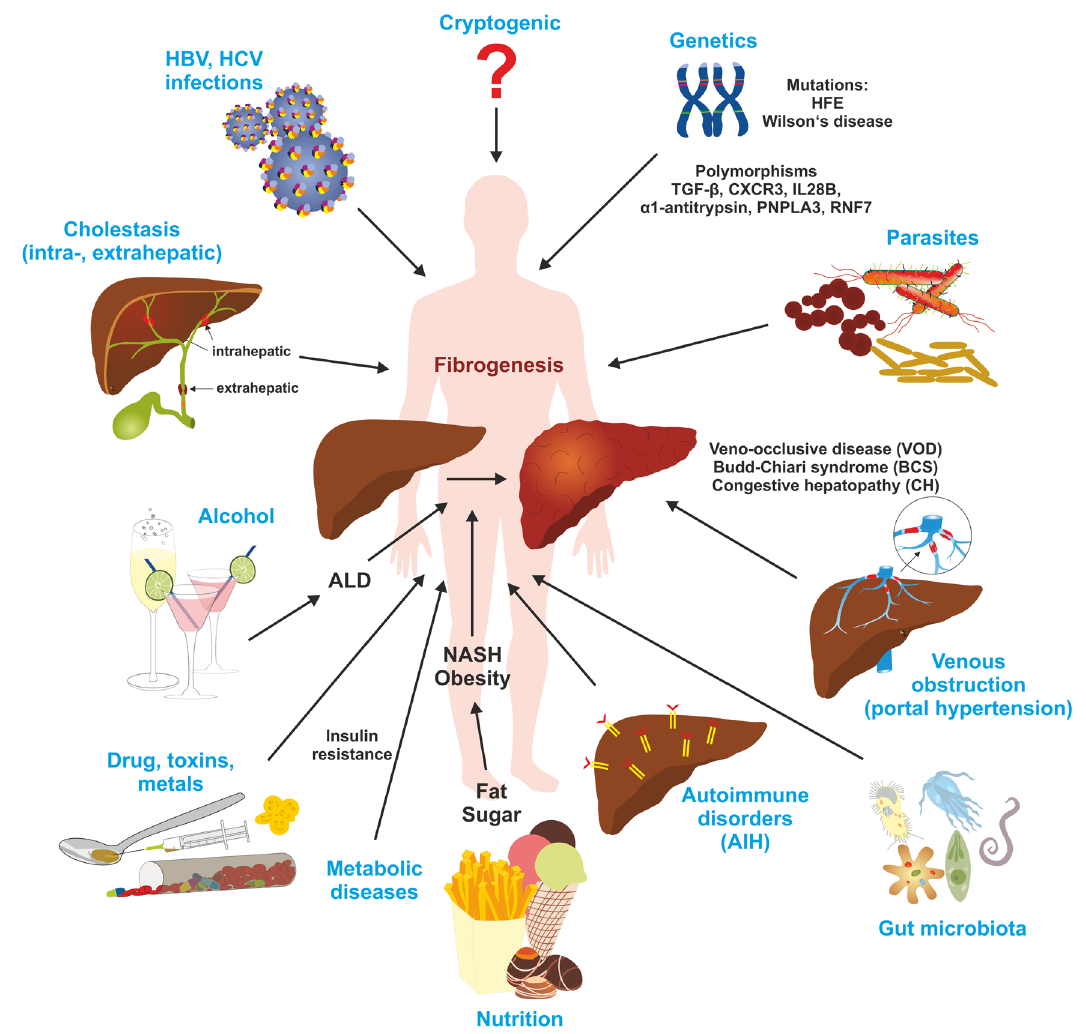
Figure 2. Major causes of hepatic fibrosis. In the liver, genetic alterations, metabolic disorders, cholestasis, viral infections, parasites, drugs, toxins, alcohol leading to alcoholic liver disease (ALD), and a wide variety of other noxious compounds and environmental factors can lead to the initiation and progression of fibrosis. AIH, autoimmune hepatitis; CXCR3, C-X-C motif chemokine receptor 3; HBV, hepatitis B virus; HCV, hepatitis C virus; IL28B, interleukin 28B; NASH, non-alcoholic steatohepatitis; PNPLA3, patatin-like phospholipase domain-containing protein 3; RNF7, ring finger protein 7; TGF- β , transforming growth factor- β .